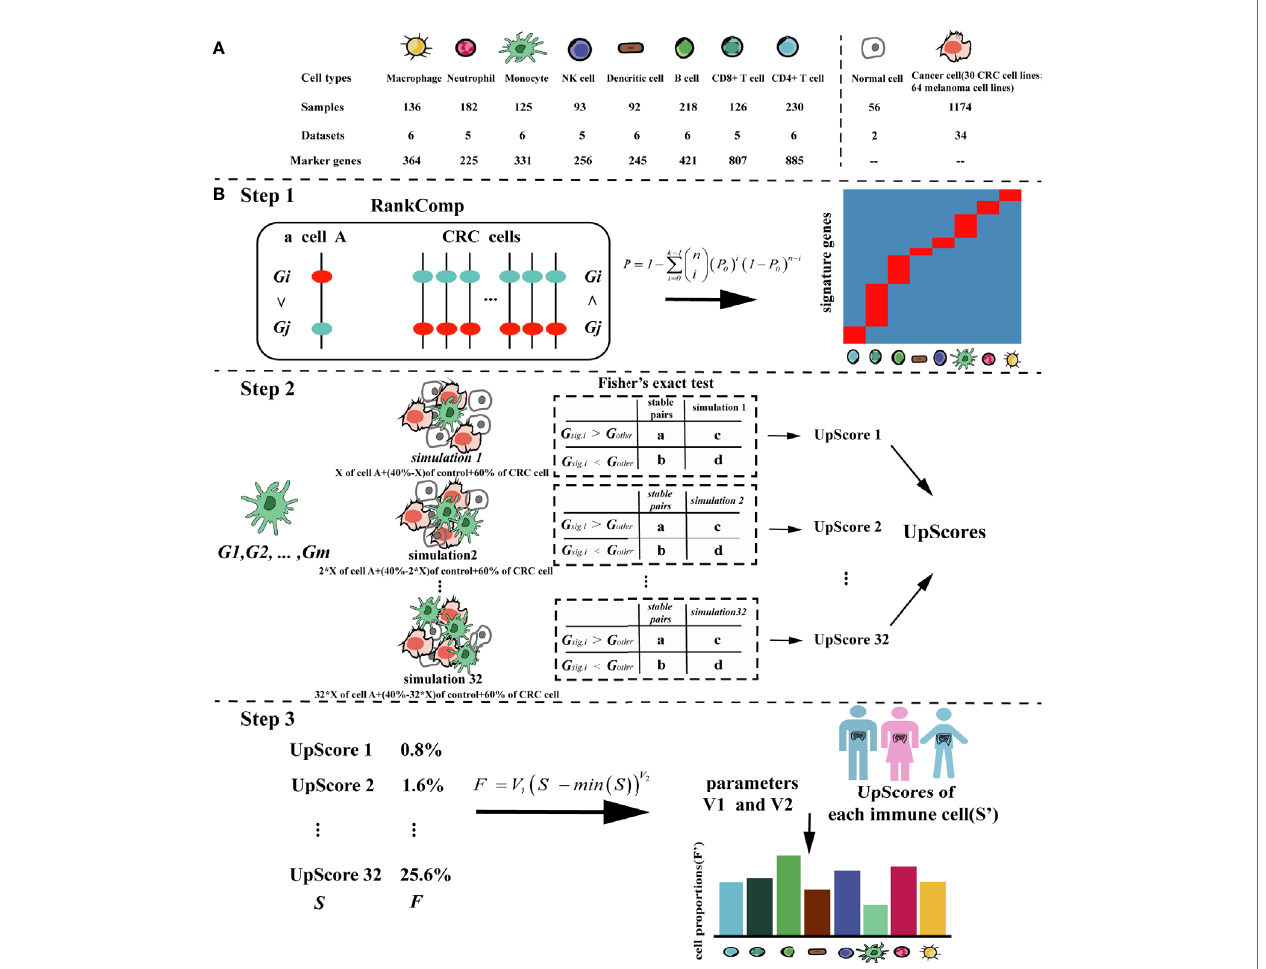
FIGURE 1 | The pipeline of the TICPE algorithm. (A) Summary of the data sources used in the study to develop the TICPE. (B) The pipeline of the TICPE algorithm. RankComp algorithm was used to identify robust signature genes compared with cancer cells for each type of immune cell from the known marker genes. The upregulated score was the reversal signi fi cance of all signature genes corresponding to the cell type. Using the simulated model for each cell type, we derived a transformation pipeline for the scores. For each queried sample, calculated upregulated scores and transformed them to estimated cell proportions using learned